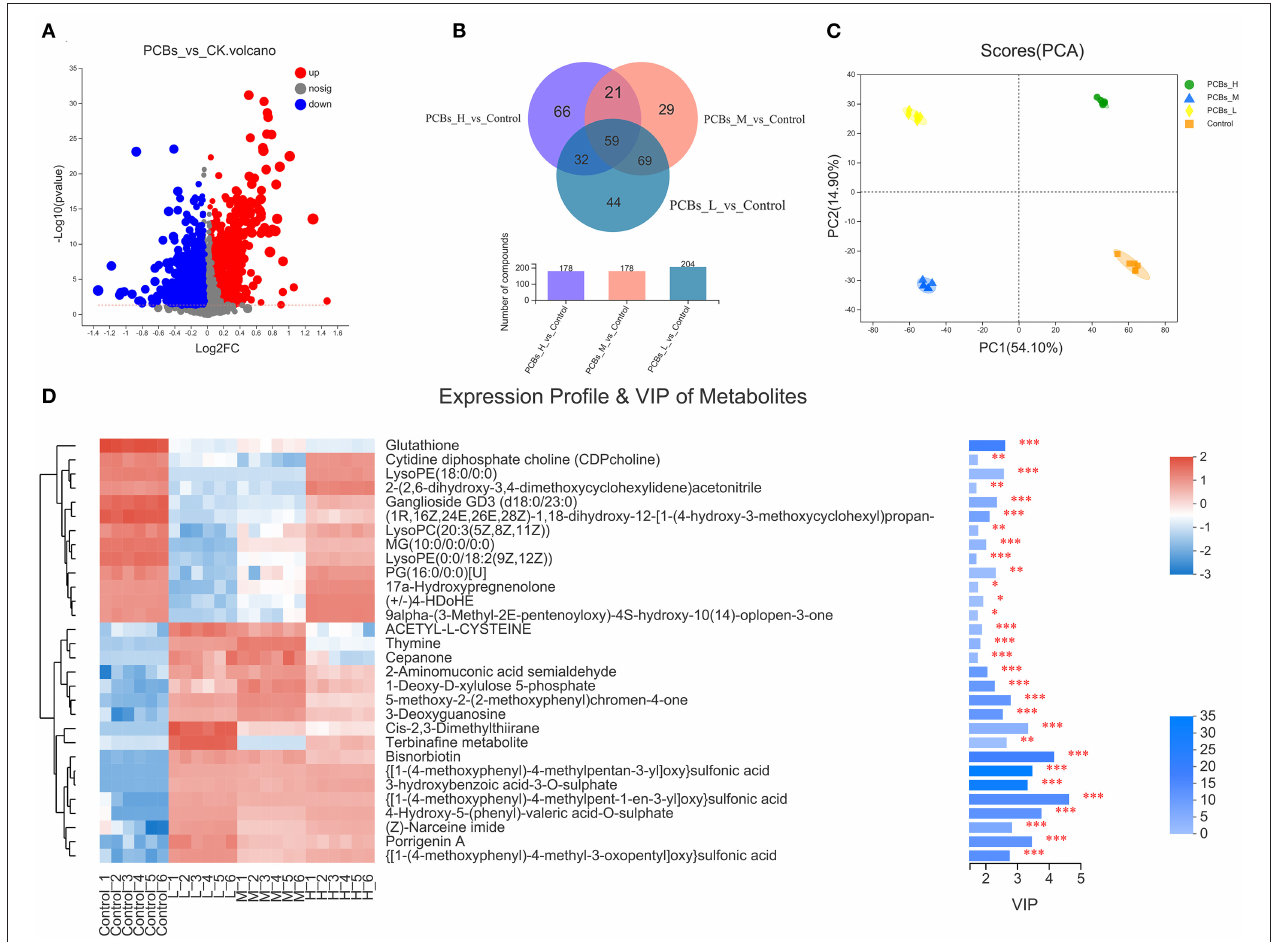
FIGURE 4 | Change map of the intestinal metabolic group [ (A) . Metabolite changes (B) . Venn diagram of metabolites in each experimental group (C) . PLS-DA diagram of metabolites in each experimental group (D) . Hierarchical clustering heat map, * P < 0.05, ** P < 0.01, *** P < 0.001].